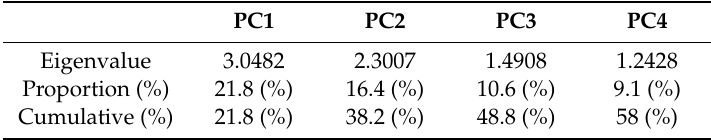
Table 5. Eigenvalue and proportions of Eigenvalues from PCA in Figure